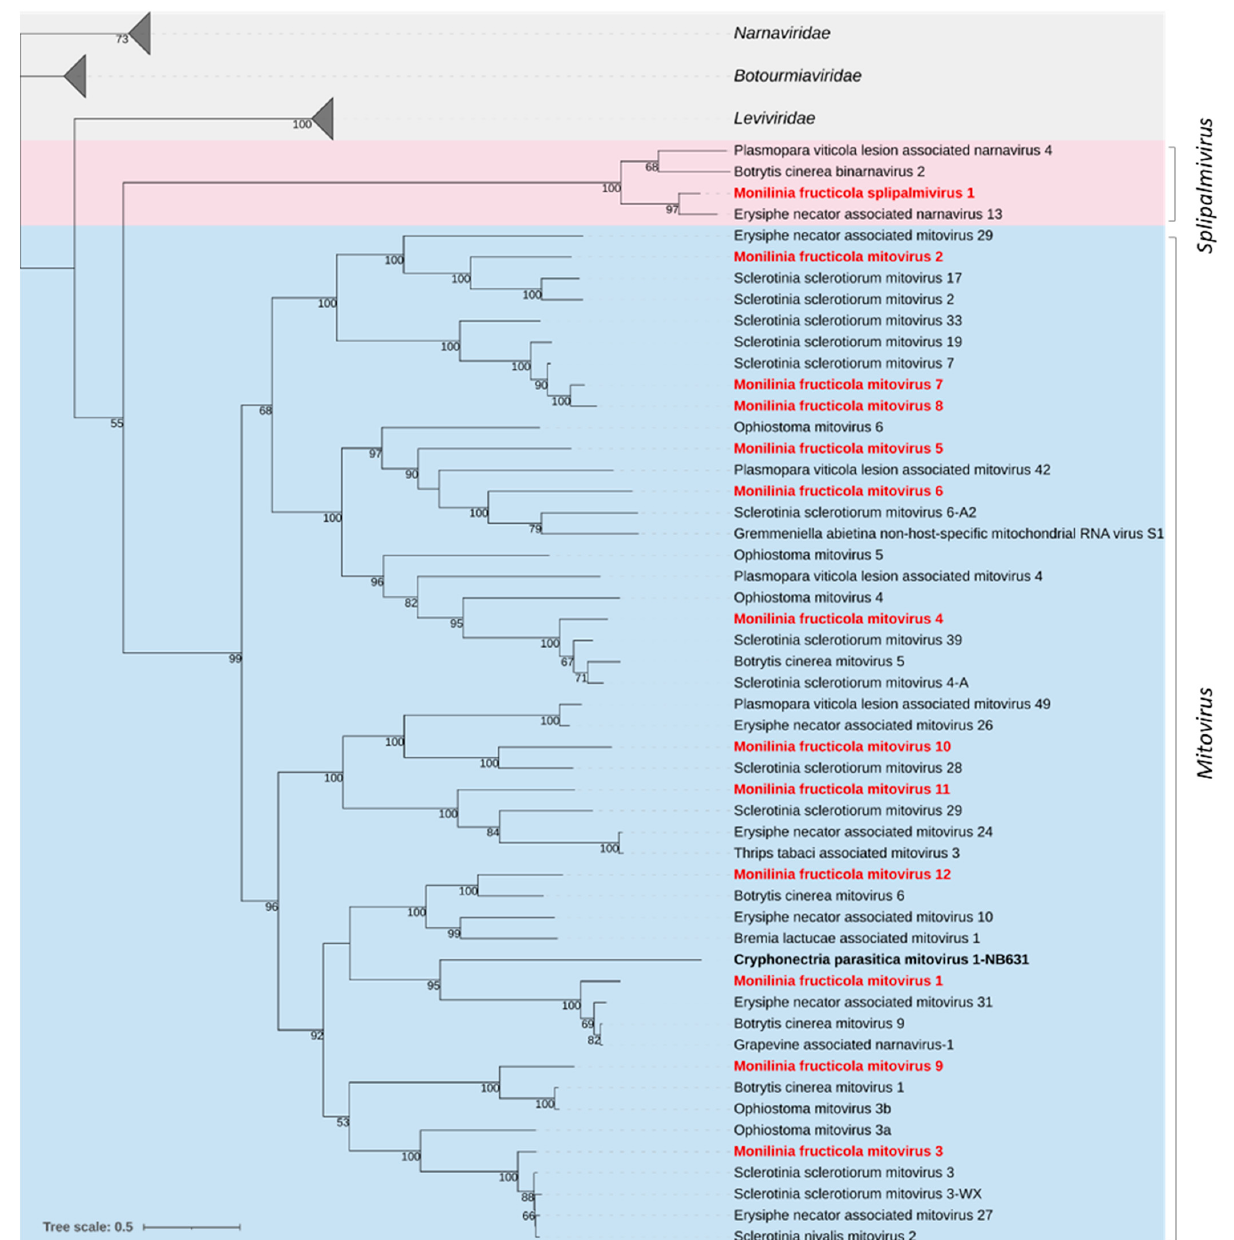
Figure 1. Maximum likelihood phylogenetic tree based on multiple amino acid sequence alignment of the RdRp proteins of viruses in the family Mitoviridae (cyan) and the proposed family Splipalmiviridae (pink; [14]), and their relationships with the closest families Leviviridae , Narnaviridae , and Botourmiaviridae in the phylum Lenarviricota . Mycoviruses found in this work are in bold red. The numbers on nodes, shown for values greater than 50%, are the results of 1000 bootstrap analyses. The scale bar represents a genetic distance of 0.5 amino acid substitutions per site. The list of accession numbers of the analysed sequences is in Table